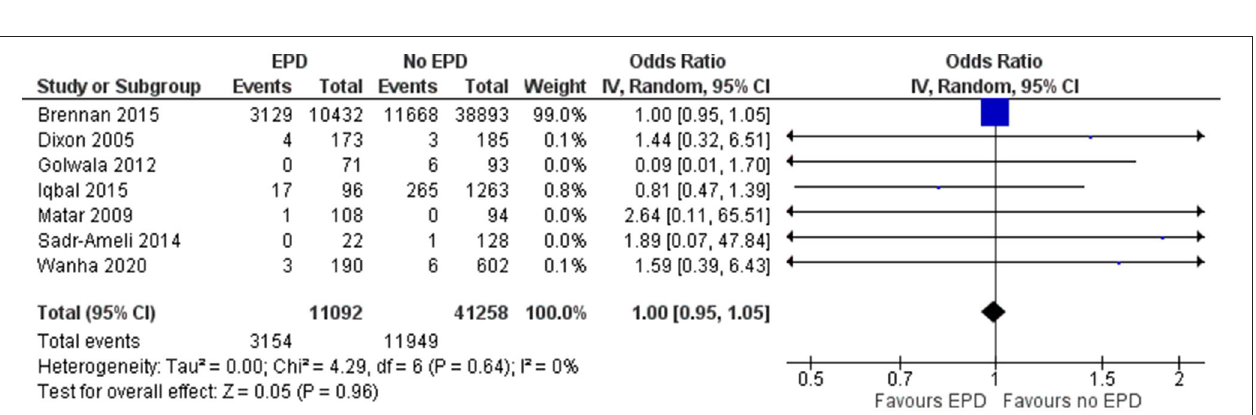
FIGURE 2 | Forest plot showing the difference in mortality between patients with and without embolic protection devices (EPD) following percutaneous coronary intervention (PCI) on saphenous vein grafts (SVG) ( n = 11).